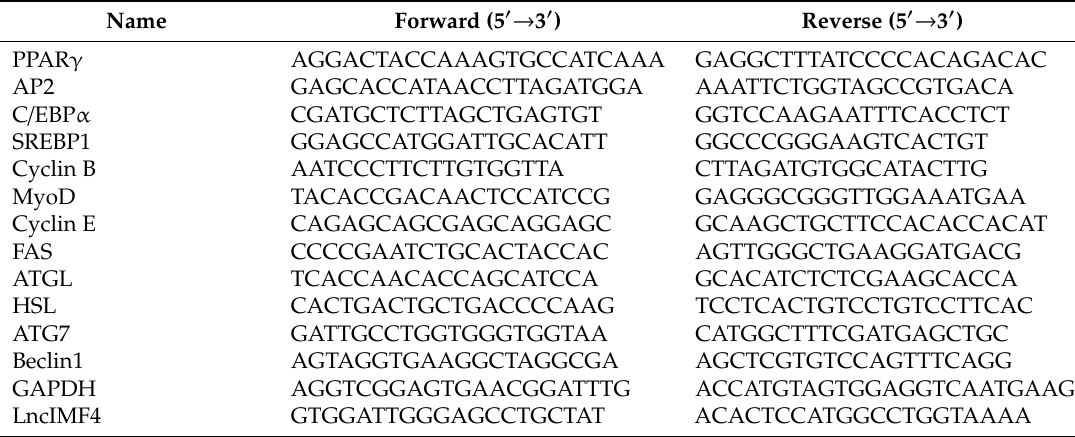
Table 1. Primers used for real-time quantitative